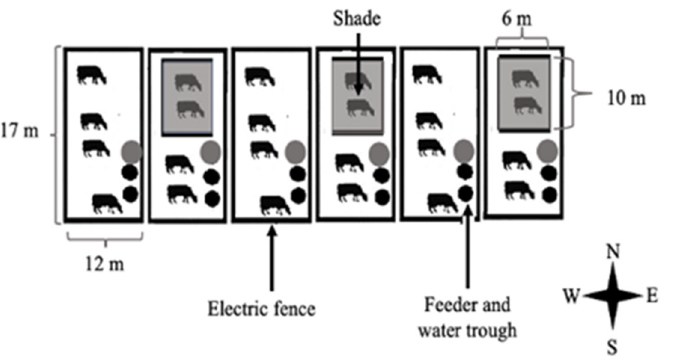
Figure 1. Illustration (not to scale) of the experimental design. Shade (grey rectangles) was oriented from the north toward the south. Feed (black circle) and water (grey circle) were located outside the shaded area.